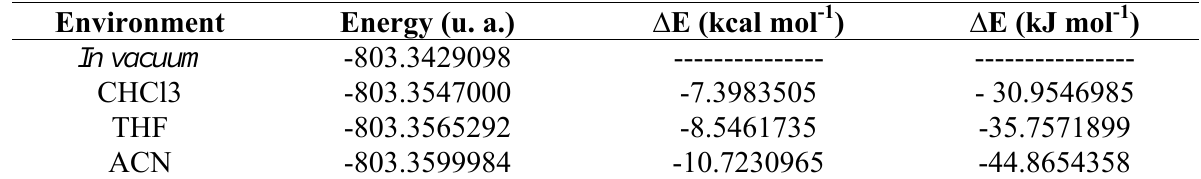
of FL in different solvents. Table 3. Δ E solv